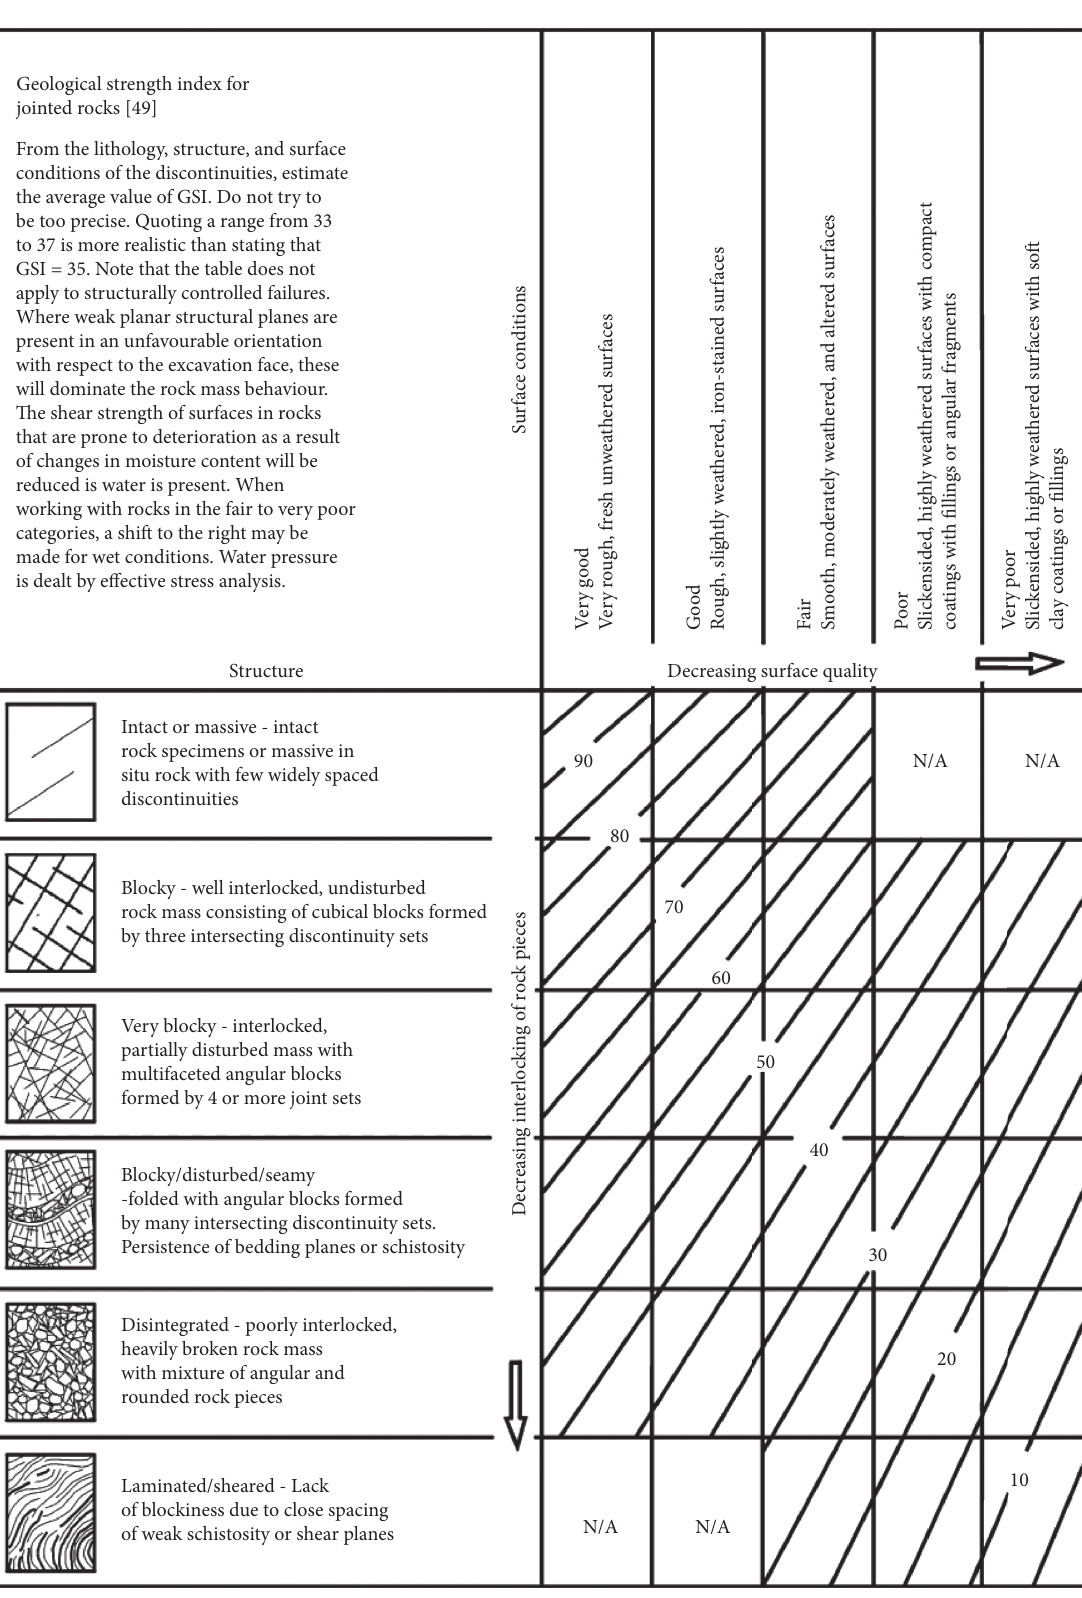
Figure 6: GSI chart for jointed rock mass [42, 45,